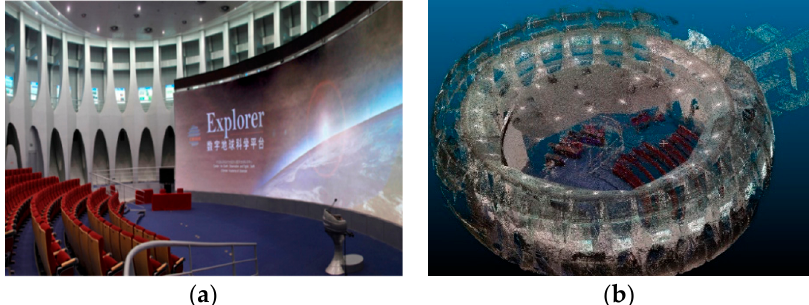
Figure 15. ( a ) Closed round hall consisting of a curved plane structure and ( b ) LiDAR point cloud data in closed round hall obtained by voxel grid downsampling. Appl. Sci. 2019 , 9 , x FOR PEER REVIEW